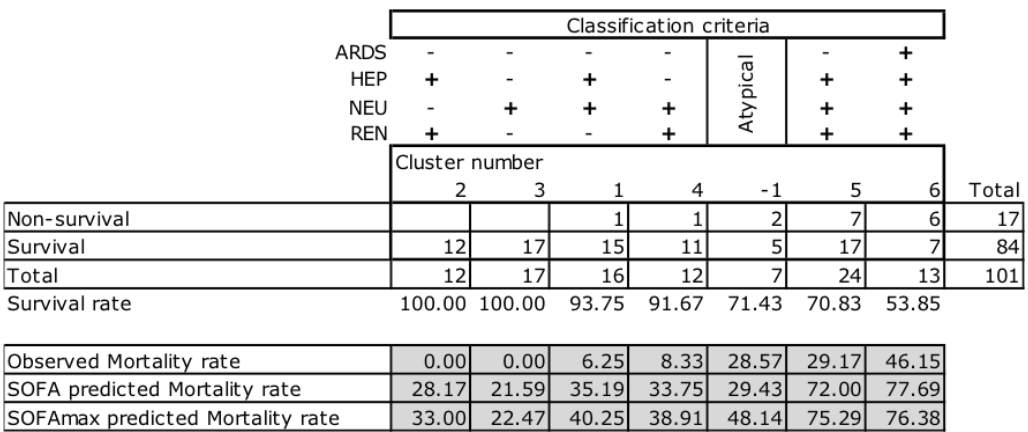
Figure 6. Classification criteria of the 6 + 1 clusters, and mortality distribution within each cluster. Survival and mortality rates are shown in % of total cases observed ( n = 101). Each column represents a numbered cluster (1–6) and one atypical cluster numbered by the software as − 1. The classification criteria defining each cluster is indicated at the top of each column/cluster for the 4 different organ dysfunctions ( n = 101; CAR and HEM not in use) that are relevant.